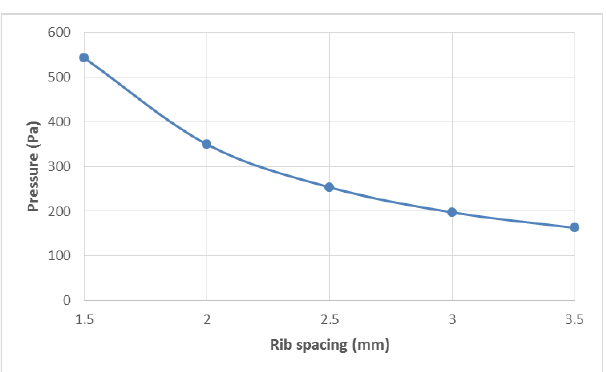
Fig. 6. Pressure loss.